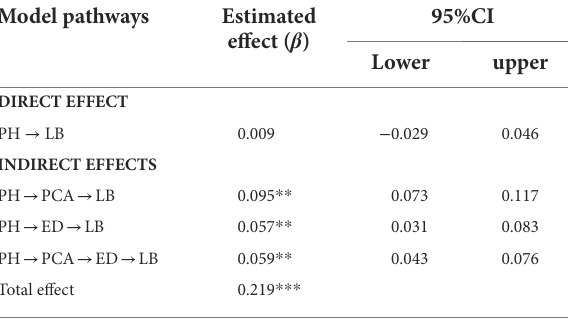
TABLE 2 Direct, indirect, and total effects of parental phubbing on learning